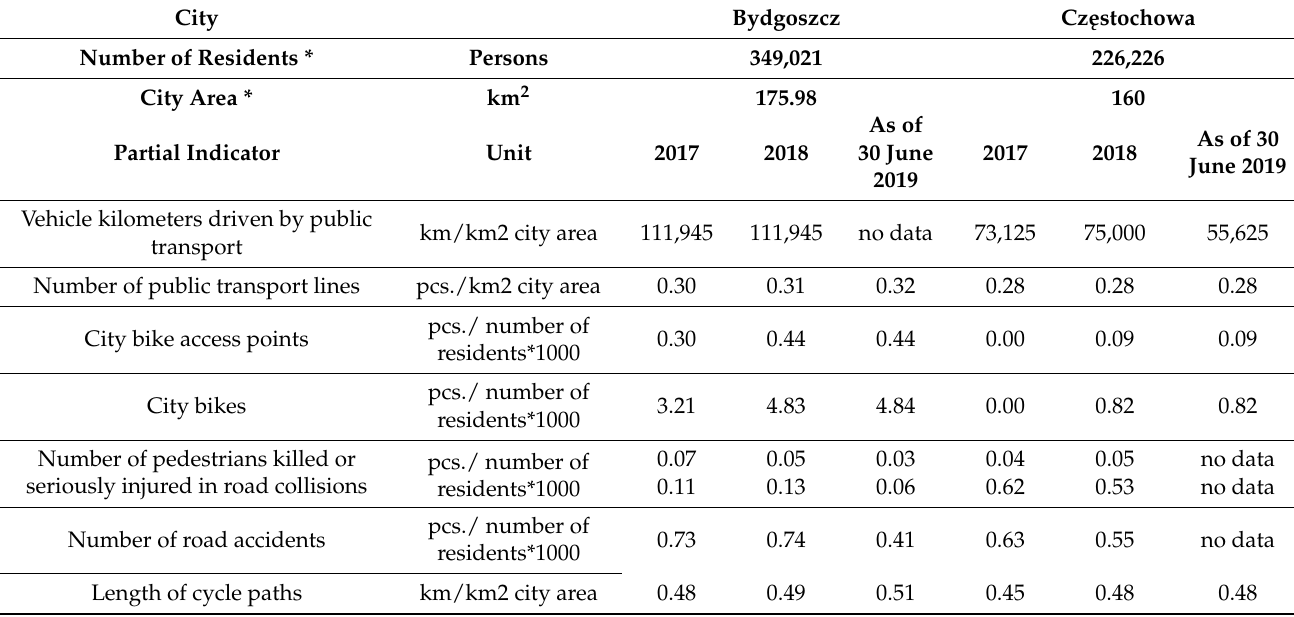
Table 7. Area 1 concerning local transport, national and international accessibility, ICT infrastructure, sustainable transport system. The measure—“local transport”—list of indicators including the variables: area and number of